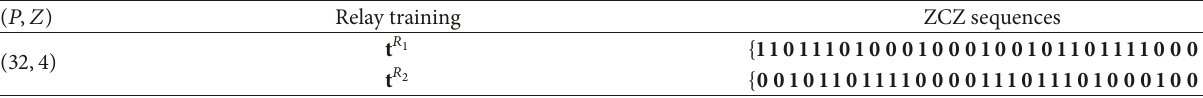
Table 1: Binary ZCZ sequence group (0 for − 1).